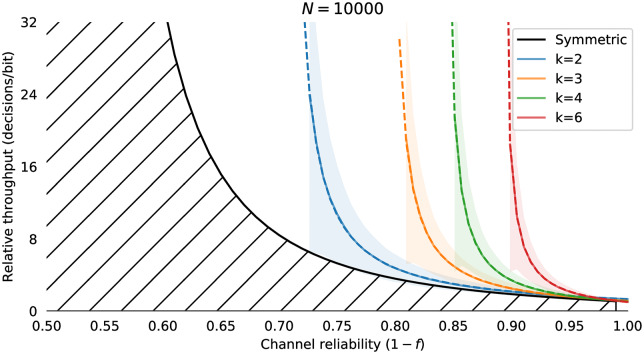
Capacity of the binary symmetric channel with backspace Rb(k, f).Capacity of backspace for alphabets with k = 2, 3, 4, 6 for N = 10000 simulated entries of a n = 32 symbol sequence. Throughput is shown as the number of input bits per correct bit R; solid lines shows the mean throughput, and the shaded region shows the standard deviation. The hatched region is the Shannon bound for the binary symmetric channel. Even with k = 2 bit symbols, capacity goes to zero as the reliability drops below 75%. Dashed lines show the fit of Eq 3.